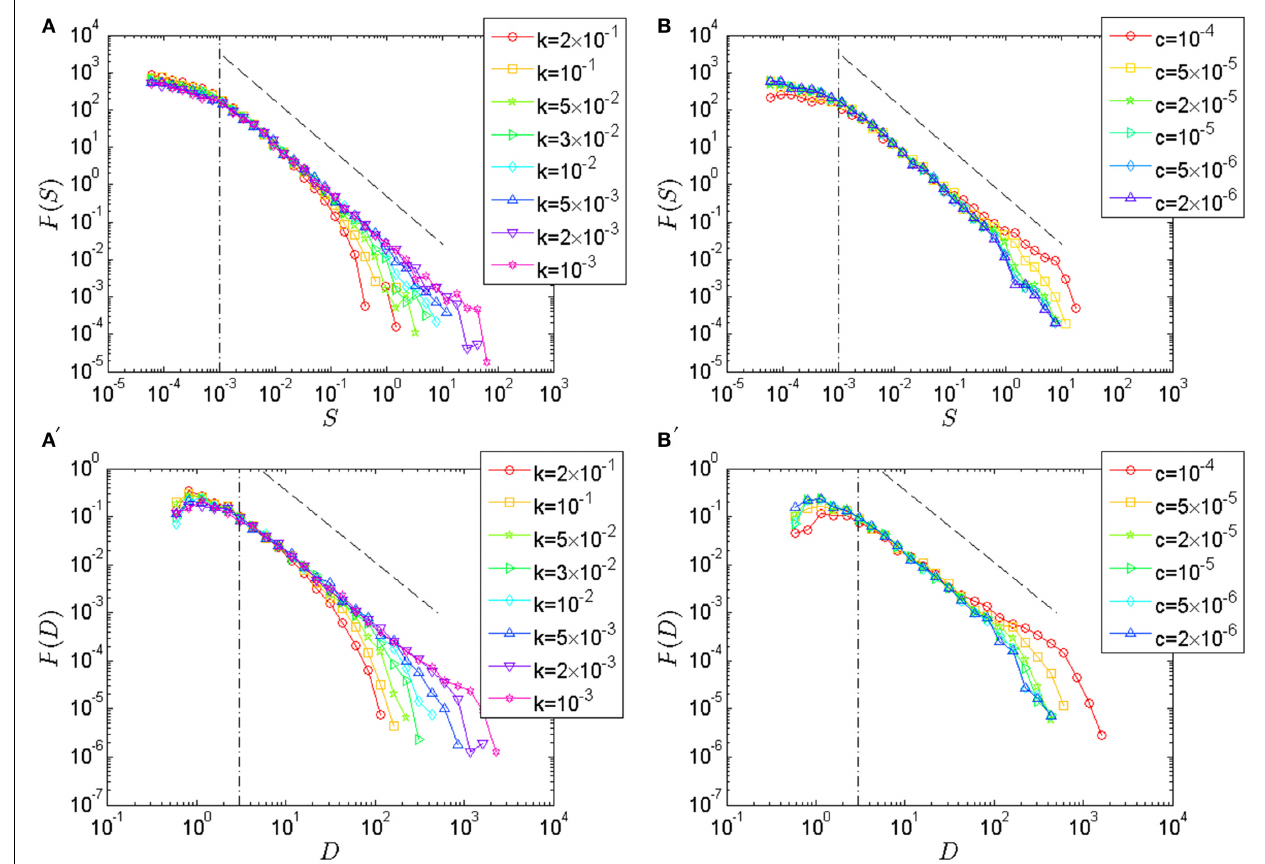
Bottom: Distribution of the avalanche duration measured (A (cid:6) ) for various values of k at constant c = 10 − 4 and (B (cid:6) ) for various values of c at constant k = 10 − 2 . In both cases, N = 1024 and ˜ η = 1 and the axes are logarithmic. The power-law exponent α is found to be independent of the parameters and compatible to the universal value α = 1 . 50 (black dashed line) predicted for c → 0 and k → 0. The lower cutoff is found to be independent of the parameters: D min ≈ 3 (vertical dash line). The upper-cutoff is found to decrease with k and to increase with c (resp. to be independent of c ) when c is large enough (resp. when c is small